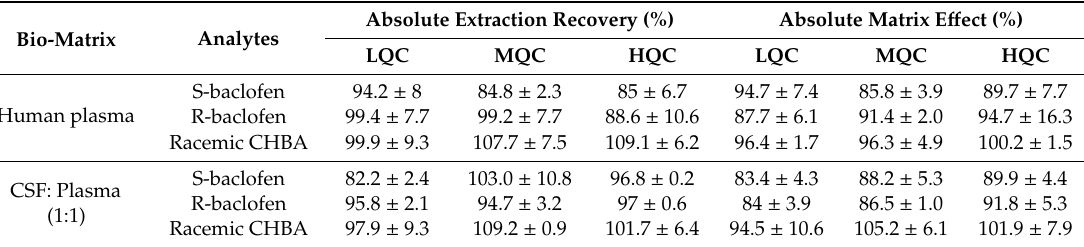
Table 3. Absolute extraction recoveries and absolute matrix e ff ects of the baclofen and its metabolite from human plasma and cerebral spinal fluid (CSF) (Mean ± SD, n =